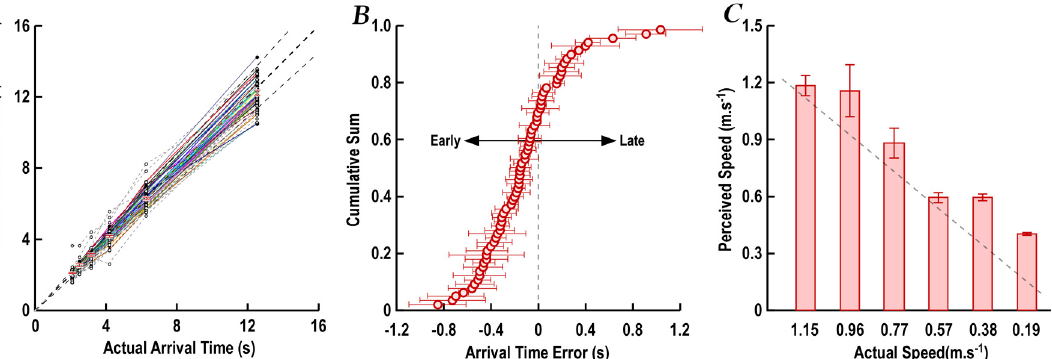
Fig 5. Perceived time to arrival and speeds of a moving object. A. Perceived arrival times are plotted against actual arrival times for each ball speed and participant. Black dots are the individual participant ’ s mean of 3 trials. The fanned parallel connecting lines indicate a high level of repeatability of relative perceived speeds across different ball speeds. Overlaid error bars are 95% confidence intervals of the means. The equality and 10% error lines are shown. B. The distribution of arrival time errors. Error bars represent the 95% CI of the mean value calculated across all trials for the participant. C. Mean ( ± SEM) perceived speed with each ball speed. The equality line indicates that participants overestimated the